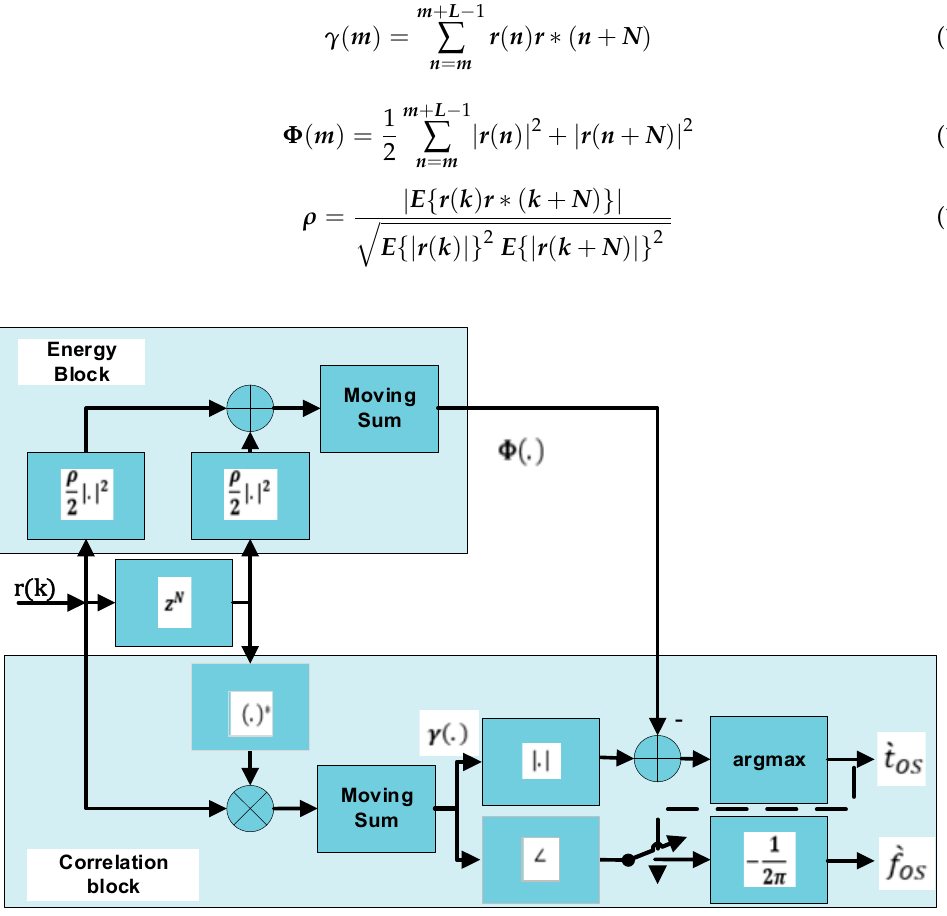
Figure 3. Structure of Van de Beek Algorithm [41]. The time and frequency offset are removed along with CP from each OFDM frame. Each OFDM frame will have N-points after CP removal. The FFT is then used to convert the time domain OFDM samples to the frequency domain OFDM samples. The expression for transforming time domain data into frequency domain data to measure CFR is pro- vided in Equation (18).